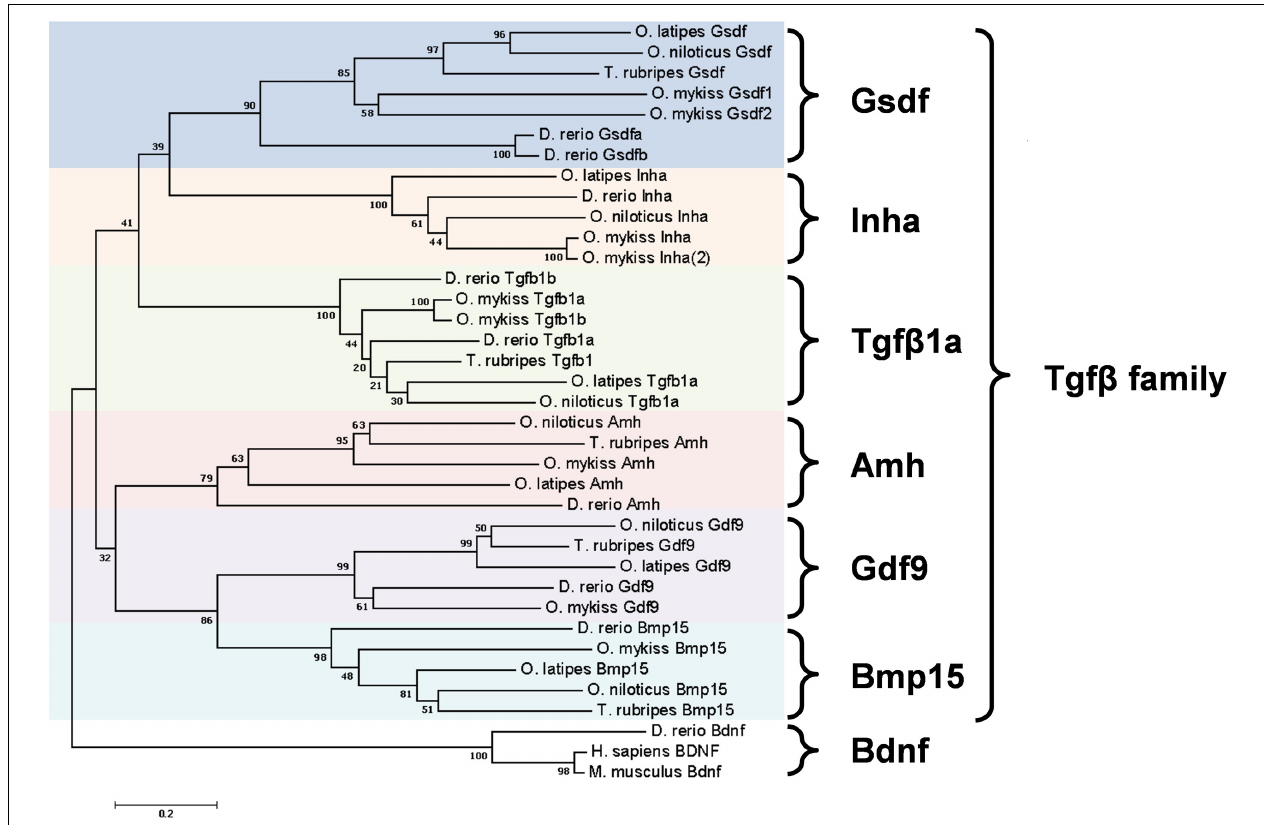
FIGURE 2 | Phylogenetic tree of six Tgf β family members in five teleost species. Danio rerio (zebrafish), Oryzias latipes (medaka), Orechromis niloticus (Nile tilapia), Oncorhynchus mykiss (rainbow trout), and Takifugu rubripes (Fugu). Phylogenetic analysis was performed by MEGA7 using nearest neighbor-joining method with 1000 bootstrap replicates. The unit of scale bar refers to the number of amino acid substitutions per site. Bdnf proteins were used as the outgroup. Amino acid sequence extracted from GenBank or Ensembl database are: D. rerio Gsdfa, ENSDARP00000149345; Gsdfb, ENSDARP00000134025; O. latipes